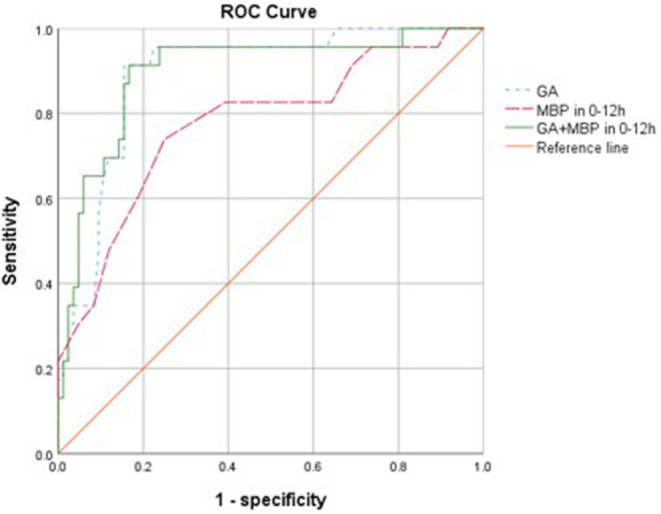
Receiver operating characteristic (ROC) curves for the ability of gestational age (GA), mean blood pressure (MBP) 0–12 h, and GA combined with MBP in 0–12 h in models to predict the development of retinopathy of prematurity with <32 weeks (n = 107). The reference line has an area of 0.50.